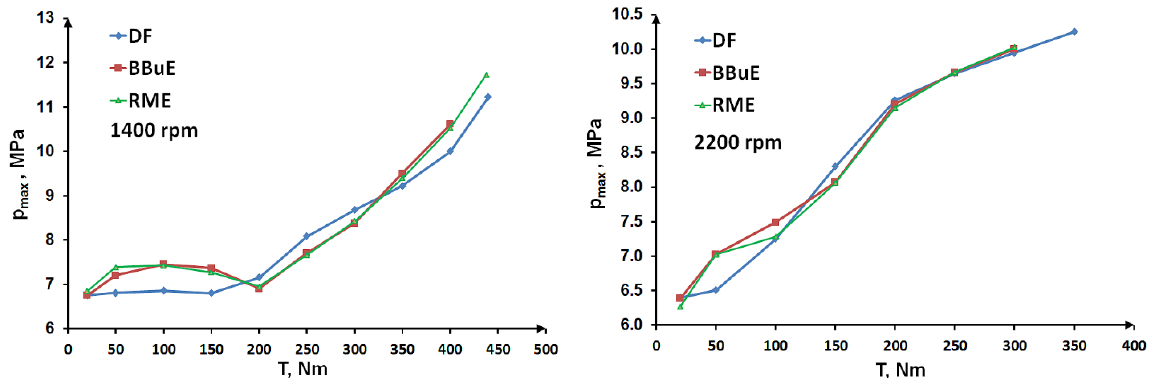
Figure 6. Maximum in-cylinder pressures during the combustion process.